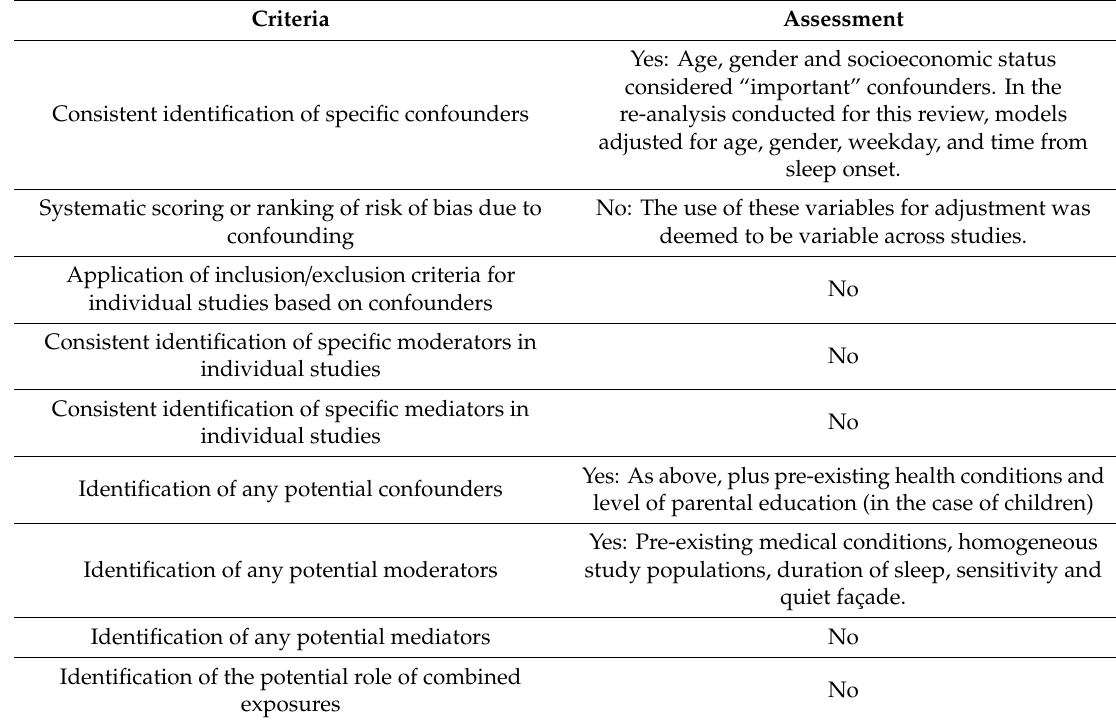
Table 3. Assessment for e ff ects on